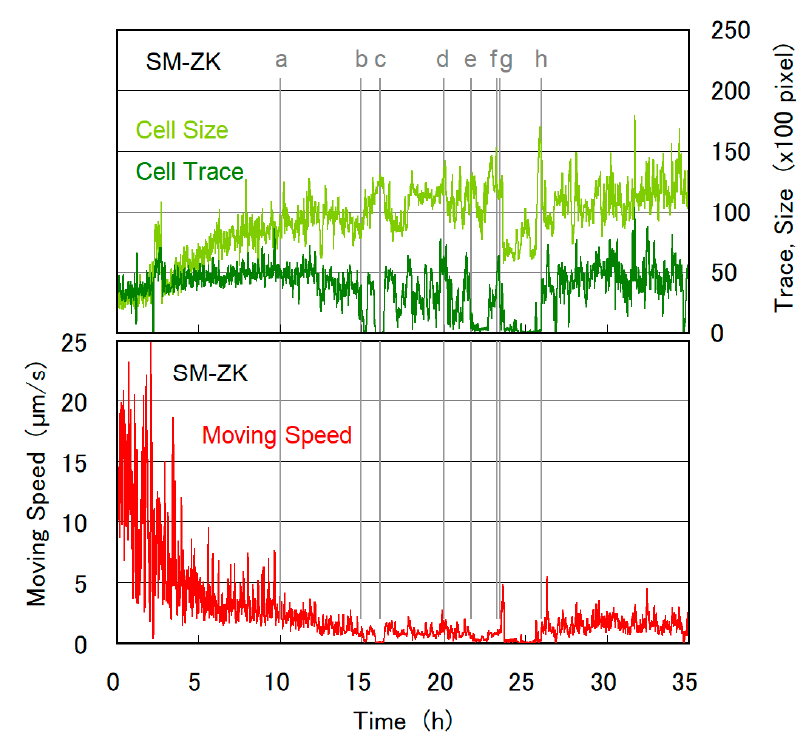
Figure 3. Temporal evolution of moving speed (velocity), cell size, and trace value obtained during the time course of cell division for an SM-ZK cell. Moving speed was calculated from XY-stage movement and the center of the gravity of the contrast image (e.g., Figure 2b). Cell size was obtained by counting red/yellow pixels in each contrast image (e.g., Figure 2b). The cell size represents the quasi-2D (10 µ m thick) volume of the cell, assuming that cell height is at a uniform height of 10 µ m. Trace value was obtained by estimating the non-zero pixels (white and red) in the trace image (e.g., Figure 2c). The trace value represents the momentum of cell movement and activity inside the cell. When the cell stops moving, the moving speed drops to zero, whereas the trace value may not become zero if the organelles move inside the cell. All of three values in Figure 3 were time-averaged for 2 min. The contrast and trace images for (a) to (h), and video-recorded images are given in Figures 4 and 5,